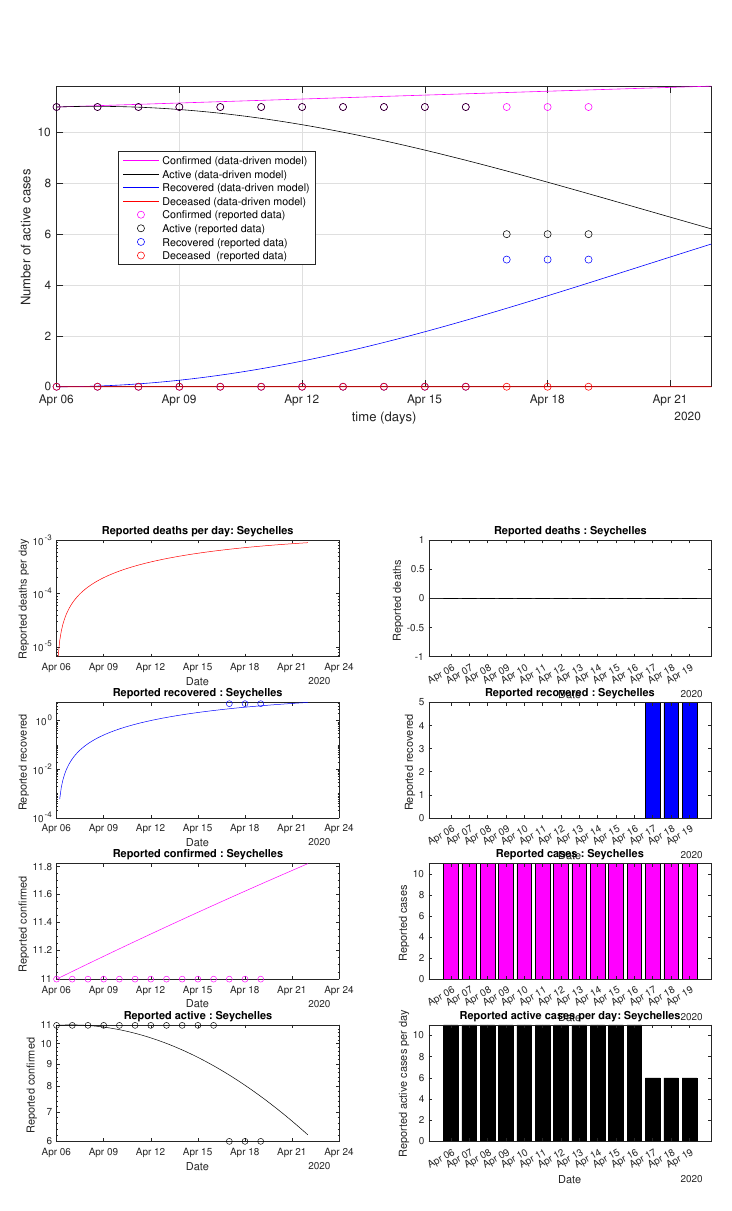
Figure 82. Seychelles: data vs.